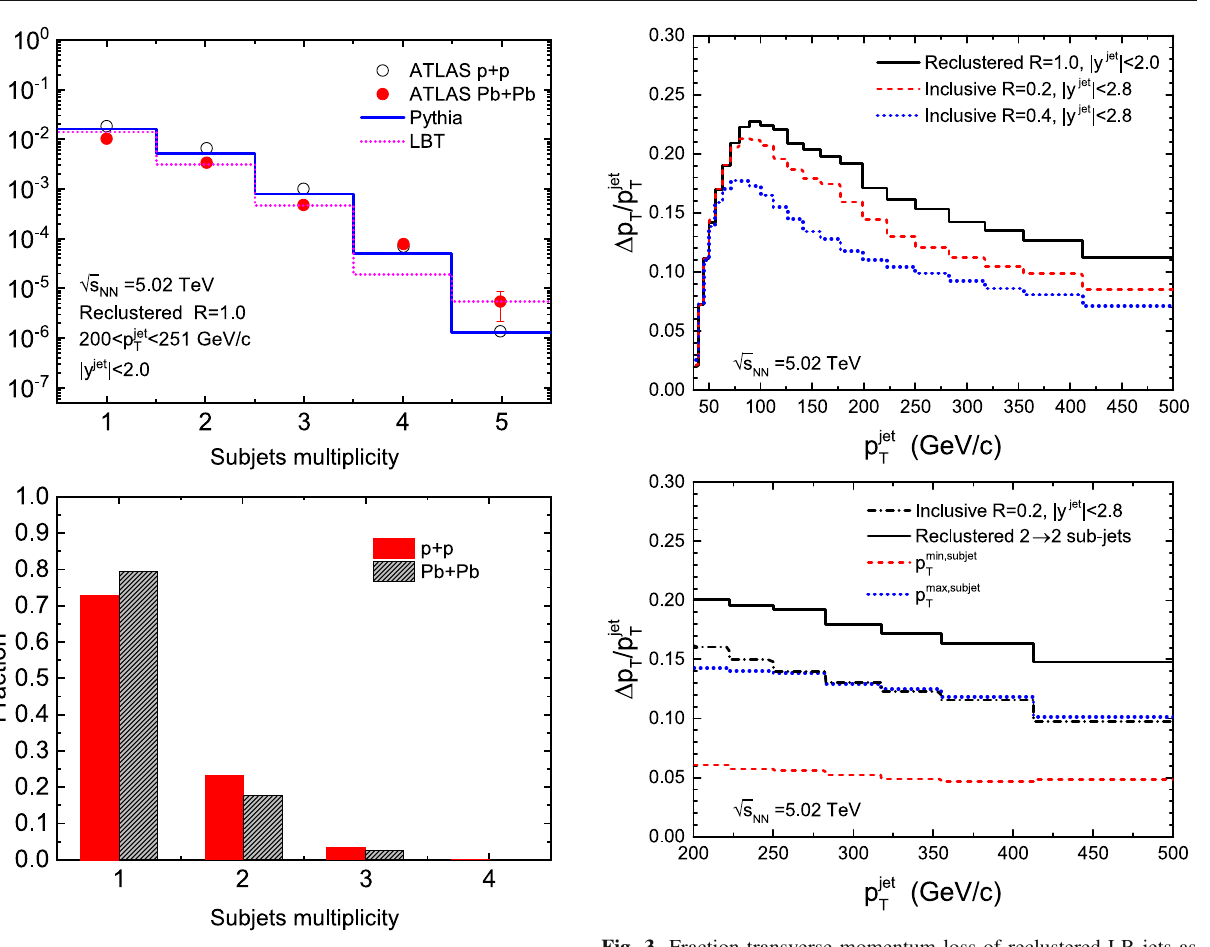
Fig. 2 Number of the subjet of reclustered LR jets before and after jet quenching and the comparison with ATLAS preliminary data (top panel). Fraction of N-subjet of reclustered LR jet in Pb + Pb and p + p collisions (bottom panel)